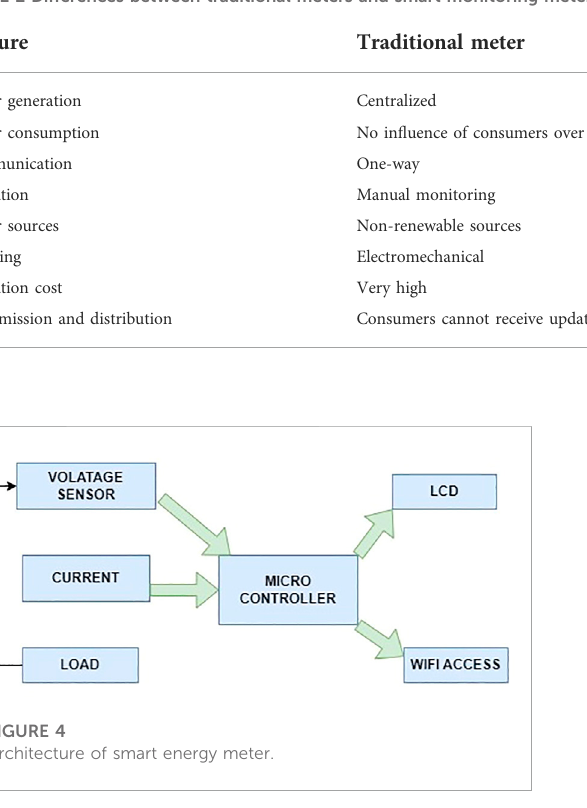
FIGURE 5 Hardware model of smart energy